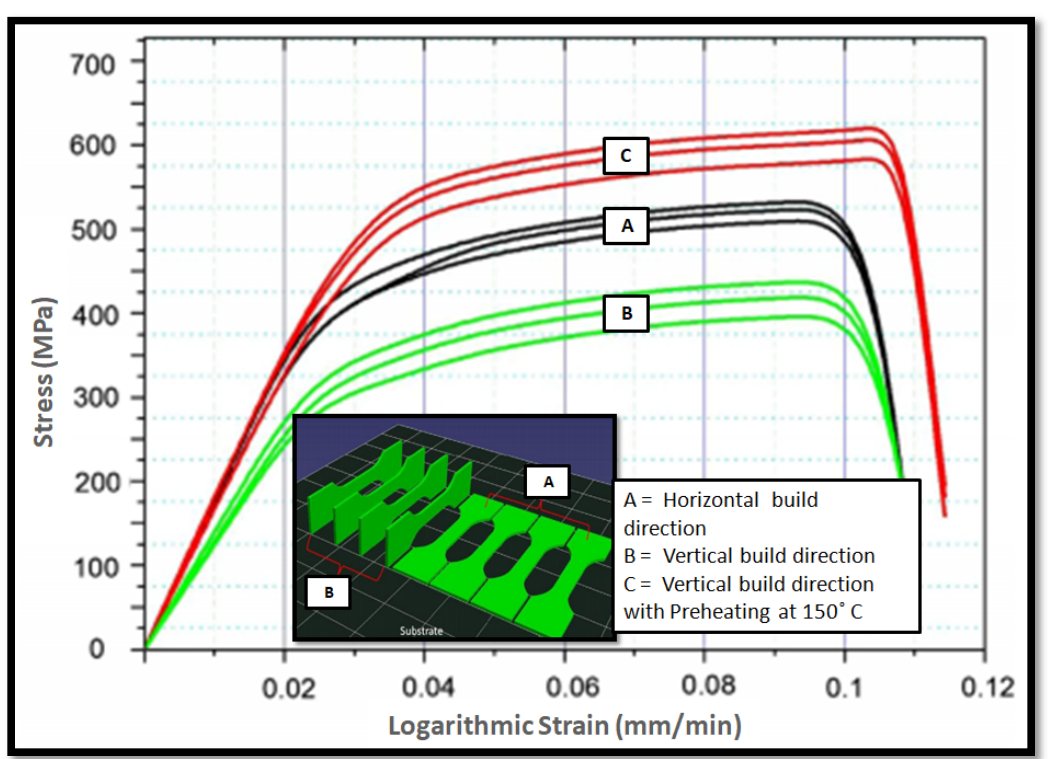
Figure 4. Tensile specimen build HZ and vertical direction with respective stress–strain curve [7].